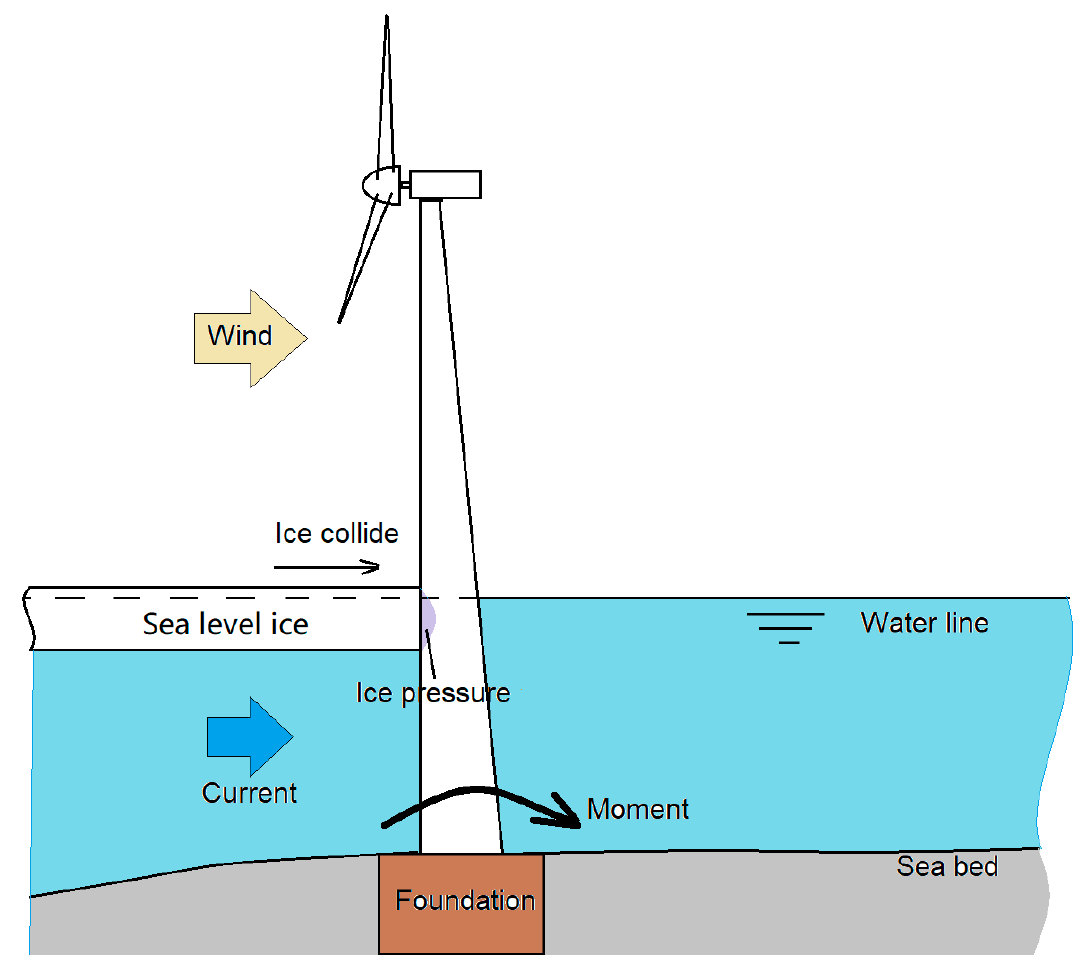
Figure 1. Wind turbine in contact with wind and ice.